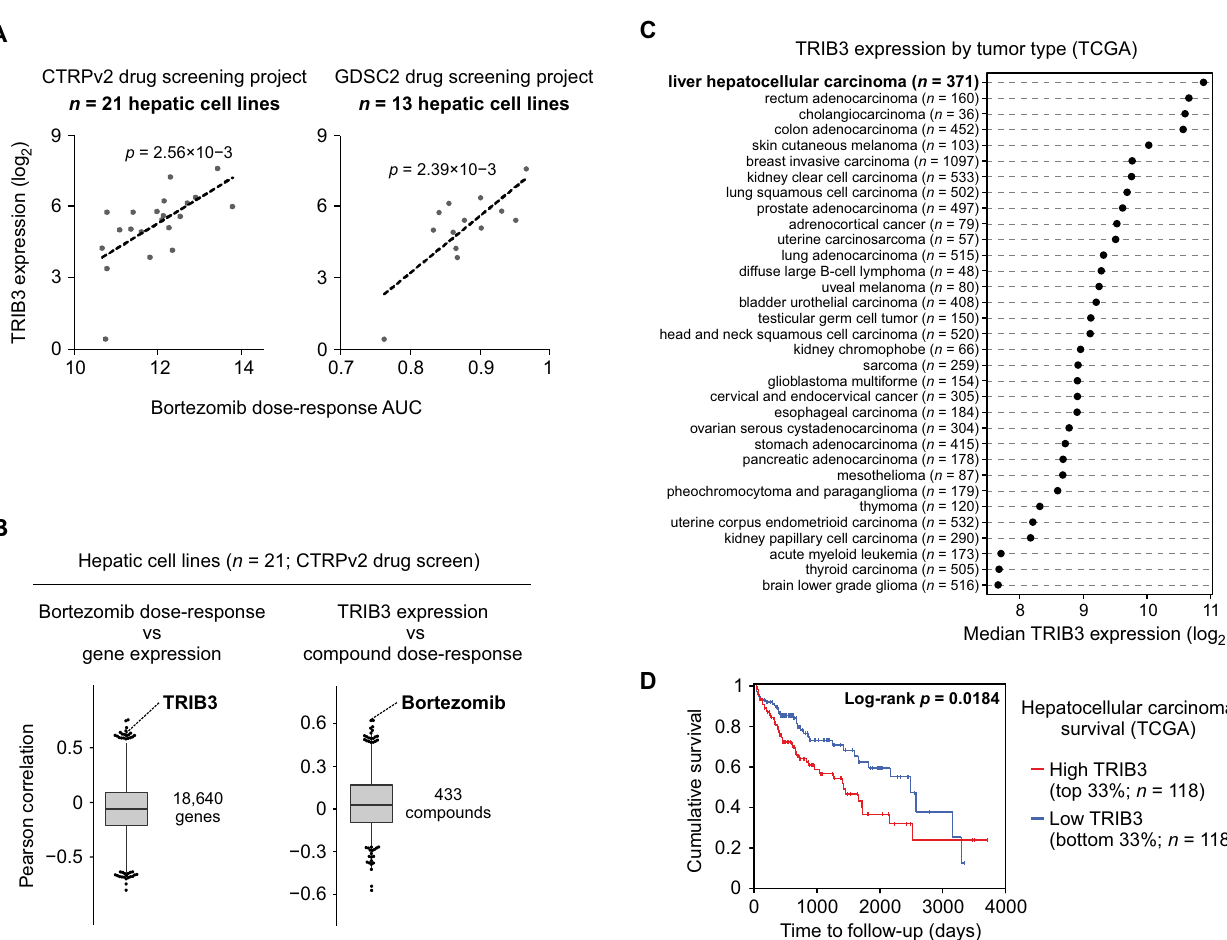
Figure 4. The expression level of TRIB3 is high in liver tumors and correlates with resistance to bortezomib in hepatic cancer cell lines. ( A ) Bortezomib sensitivity data from two drug screening projects combined with the RNA-Seq gene expression data of the liver cancer cell lines studied. The linear regression p value is shown. ( B ) Reciprocal high ranking of the relationship between TRIB3 gene expression level and bortezomib dose-response in hepatic cancer cell lines. Correlation was calculated between bortezomib dose-response and all expressed genes (left panel), or between TRIB3 gene expression and all studied compounds (right panel). ( C ) TRIB3 gene expression level by tumor type. The Cancer Genome Atlas (TCGA) RNA-Seq data from primary tumor samples was used. ( D ) High TRIB3 expression is associated with poor survival in hepatocellular carcinoma patients. TCGA samples were stratified by their TRIB3 mRNA level (top and bottom 33%) and subjected to survival